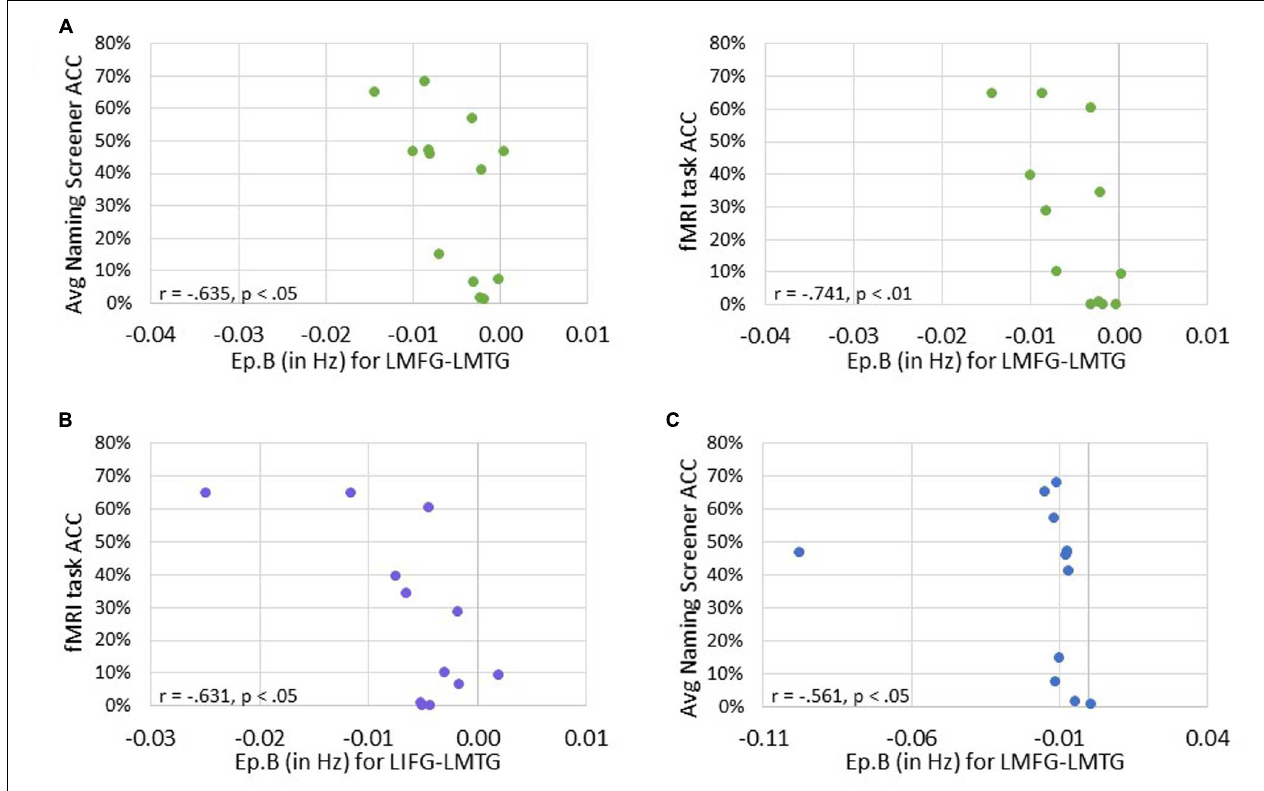
FIGURE 9 | Correlations between behavioral performance and strength of the connections (i.e., Ep.B values in Hz). (A) For family #1, significant correlations were found between the connection strength of LMFG → LMTG and behavioral accuracy on the naming screener (shown on the left) and the fMRI task (shown on the right). (B) For family #2, a significant correlation was found between the connection strength of LIFG → LMTG and fMRI task accuracy. (C) For family #3, a significant correlation was found between the connection strength of LMFG → LMTG and the average naming screener